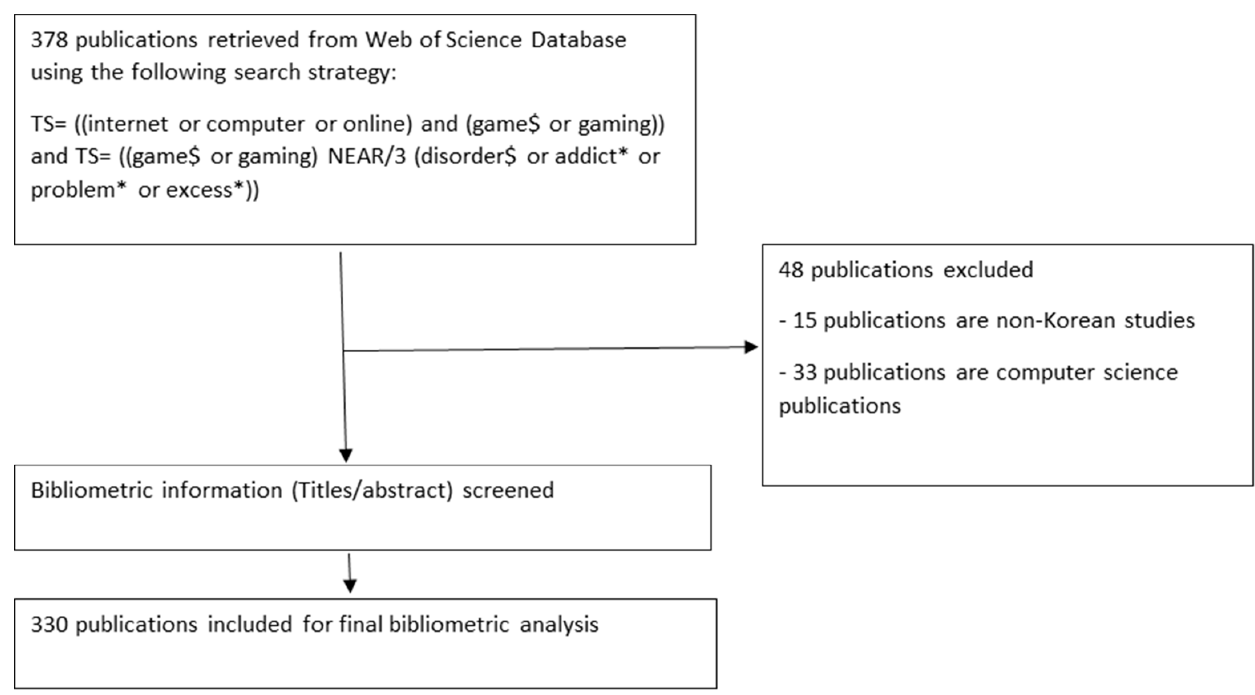
Figure 1. Overview of the study selection process.